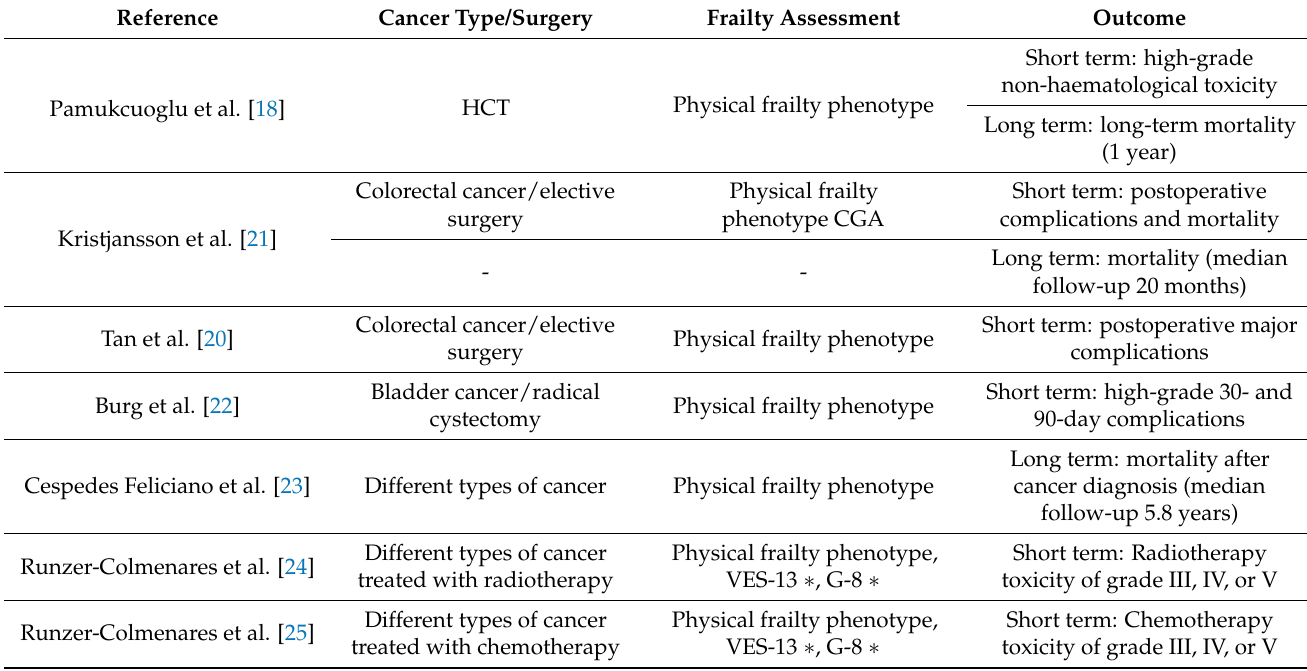
Table 1. Summary of core studies on frailty in older people with cancer and related clinical outcomes on the basis of the two main frailty constructs (i.e., Fried and Rockwood